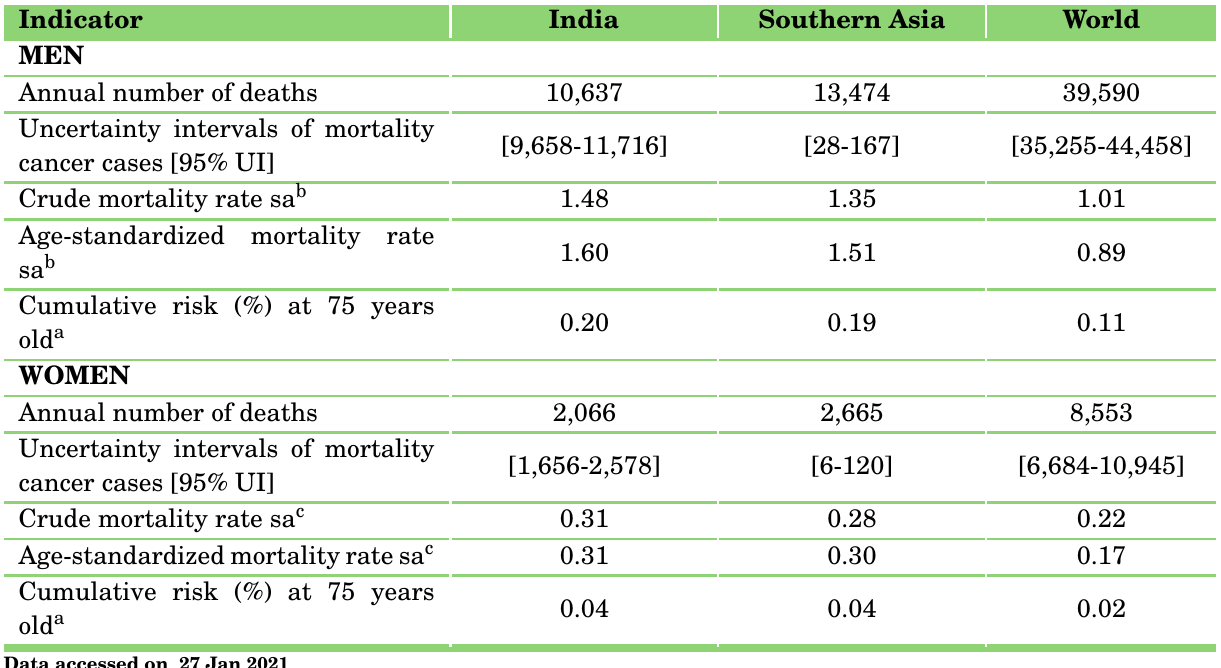
Table 16: Oropharyngeal cancer mortality in India (estimates for 2020) Indicator India